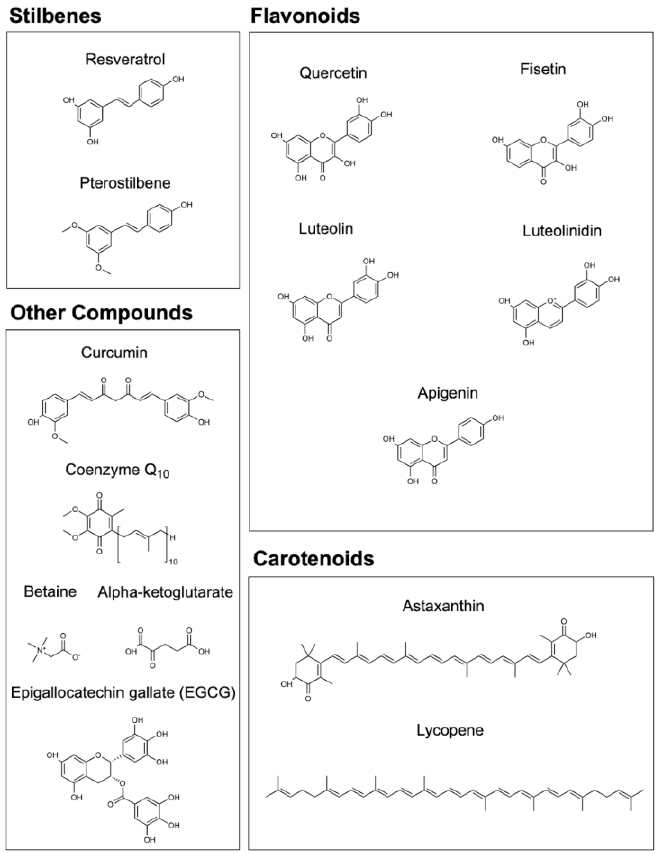
Figure 2. Chemical structures of the aforementioned nutraceutical compounds are organized into their respective categories.